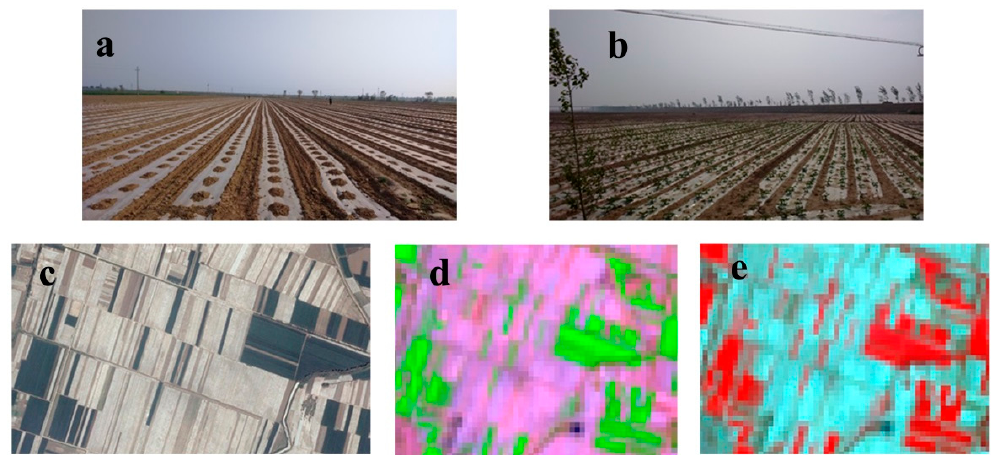
Figure 2. The plastic-mulched farmland in the study area: ( a ) field photo of plastic-mulched farmland at sowing stage; ( b ) field photo of plastic-mulched farmland at seedling stage; ( c ) plastic-mulched farmland in the Google Earth imagery; ( d ) plastic-mulched farmland presented in false color composite Landsat-8 OLI imagery: R = SWIR2 (Shortwave Infrared 2), G = NIR, B = red; and ( e ) plastic-mulched farmland presented in false color composite Landsat-8 OLI imagery: R = NIR, G = red, B = green.